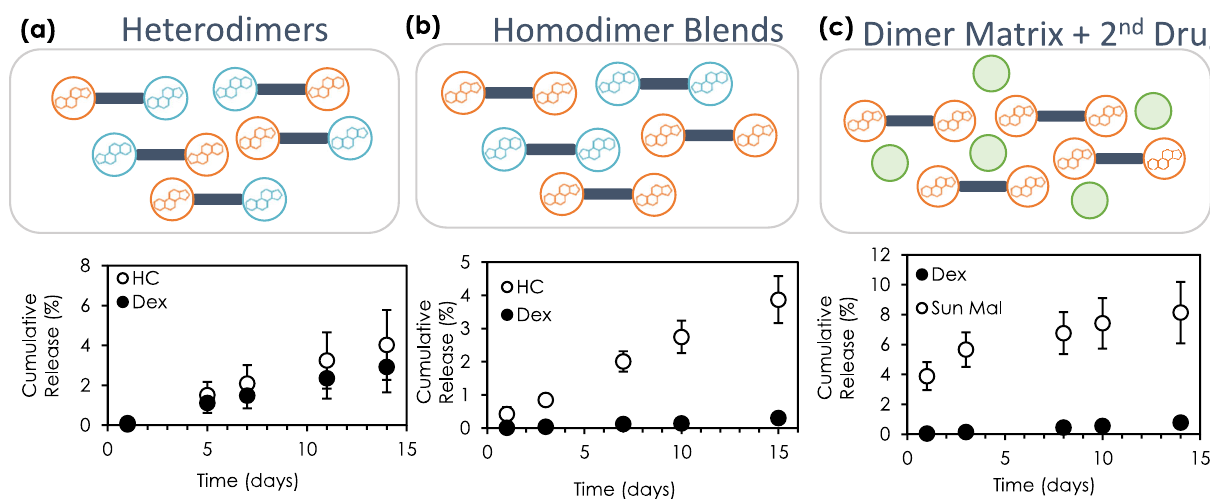
Fig. 6 Formulation strategies for achieving multi-drug release with corticosteroid dimer materials. a Release kinetics for Dex and HC from a Dex-TEG- HC heterodimer (4 ml PBS, 1 mm × 1 mm height × diameter pellets, 0.18 ± 0.08 mg HC and 0.19 ± 0.08 mg Dex loading) ( N = 3 samples). b Processing of two different corticosteroid homodimers (Dex-TEG-Dex and HC-TEG-HC) into a solid implant that gives controlled release of both drugs. (4 ml PBS, 1 mm × 1 mm height × diameter pellets, 0.51 ± 0.05 mg Dex and 0.35 ± 0.03 mg HC total loading) ( N = 3 samples). c Use of a dimer (Dex-TEG-Dex) to provide a matrix for the support, distribution, and controlled release of Dex and a second drug (sunitinib malate). Dex-TEG-Dex:Sunitinib malate 7:1. (4 ml PBS, 1 mm × 1 mm height× diameter pellets, 0.83 ± 0.14 mg Dex and 0.15 ± 0.02 sunitinib malate loading). N = 3 samples. In all panels, data represent the mean ± standard deviation. Orange and blue circles represent different corticosteroids. Dark blue rectangles indicate the linker. Green circles represent free drug contained within the dimer